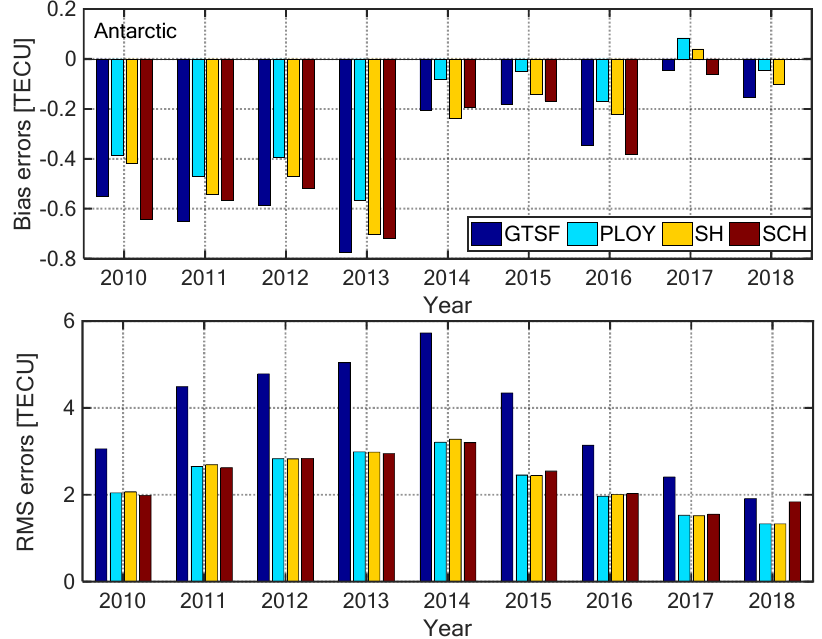
Figure 4. Annually ionospheric TEC mapping bias ( top ) and RMS ( bottom ) errors of the four models in the Antarctic from 2010 to 2018.